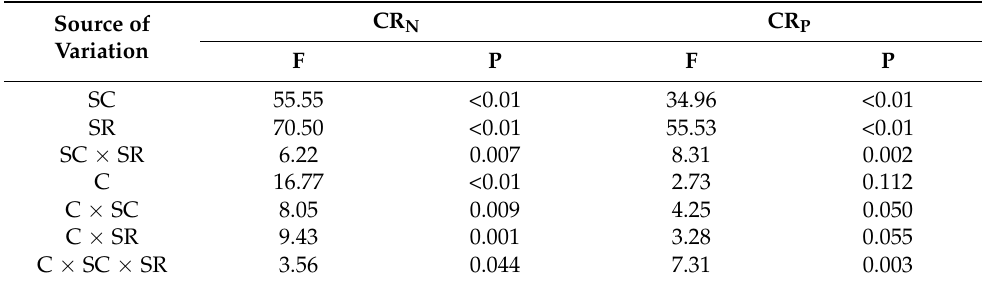
Table 5. Three-way ANOVAs on effects of species combination (SC), sowing ratio (SR), and cut (C) on competitive ratios for N (CR N ) and P (CR P ) of